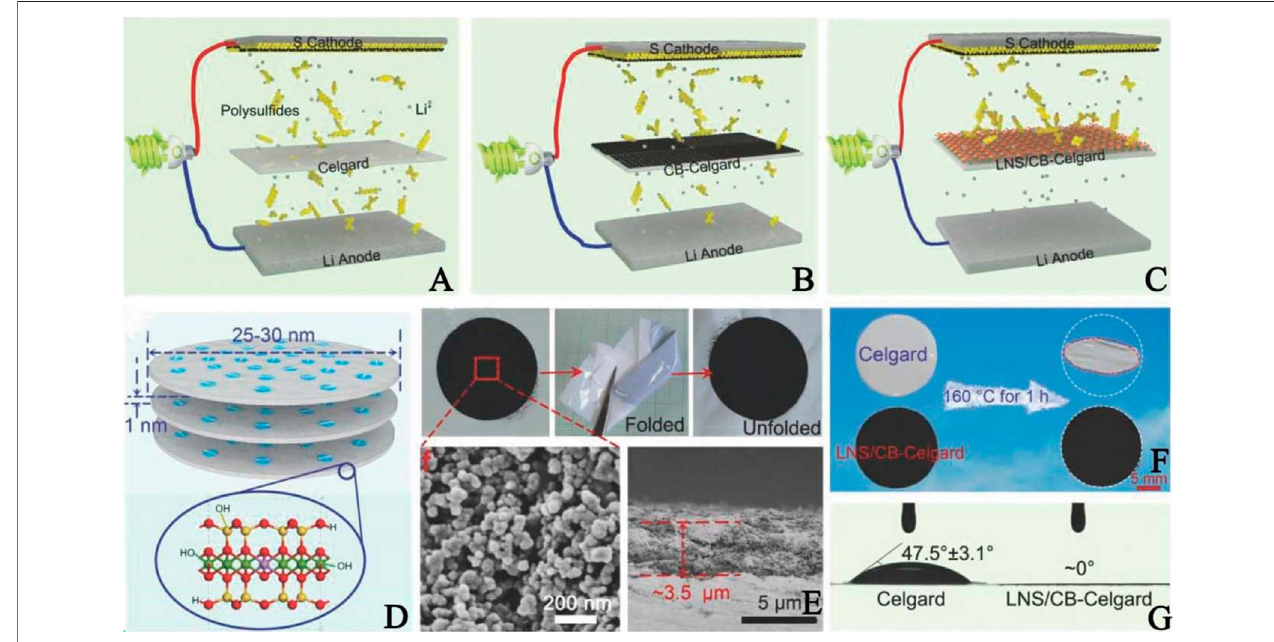
FIGURE 6 | Schematic illustrations of LSBs with the (A) Celgard (B) CB-Celgard (C) LNS/CB-Celgard separators, and (D) the structure of the LNS (E) Photographs, SEM and cross-sectional images of the LNS/CB-Celgard separator (F) Dimension shrinkage of the separators after storage at 160 ° C for 1 h (G) Contact angles tests. Reproduced with permission from (Yang and Zhang,